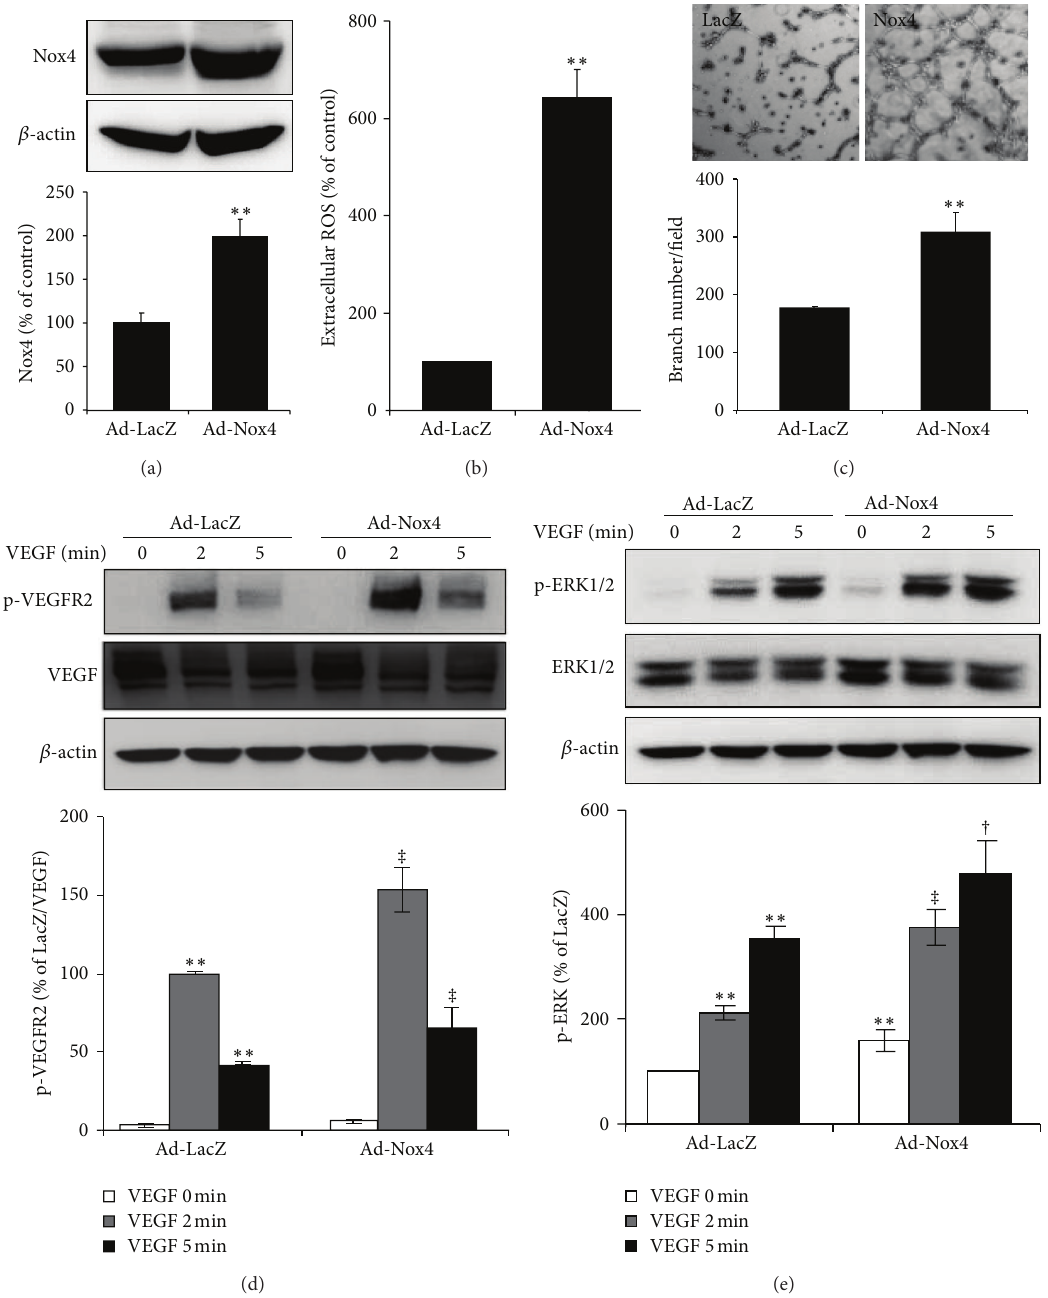
Figure 3: Overexpression of Nox4 promotes endothelial tube formation and augments VEGFR2 activation in HRECs. HRECs were transduced with Ad-LacZ and Ad-Nox4 for 48 h and subjected to biochemical and functions analyses. (a) Expression of Nox4 was determined by Western blot analysis and semiquantified by densitometry. 𝑛 = 3 ; ∗∗ 𝑃 < 0.01 versusAd-LacZ. (b) Generation of extracellular ROS was measured by Amplex red assay. 𝑛 = 3 ; ∗∗ 𝑃 < 0.01 versus Ad-LacZ. (c) Tube formation of HRECs capacity was evaluated by Matrigel assay. Adenoviral-transducedHRECswereseededonMatrigelfor6handtubenumberswerecountedfrom3randomvisualfields. ∗∗ 𝑃 < 0.01 versus Ad-LacZ. Results represent 3 independent experiments. (d-e) Phosphorylation of VEGFR2 (d) and ERK (e) induced by VEGF (50ng/mL) was determined by Western blot analysis and semiquantified by densitometry. 𝑛 = 4 ; ∗∗ 𝑃 < 0.01 versus Ad-LacZ and † 𝑃 < 0.05 or ‡ 𝑃 < 0.01 versus Ad-LacZ with